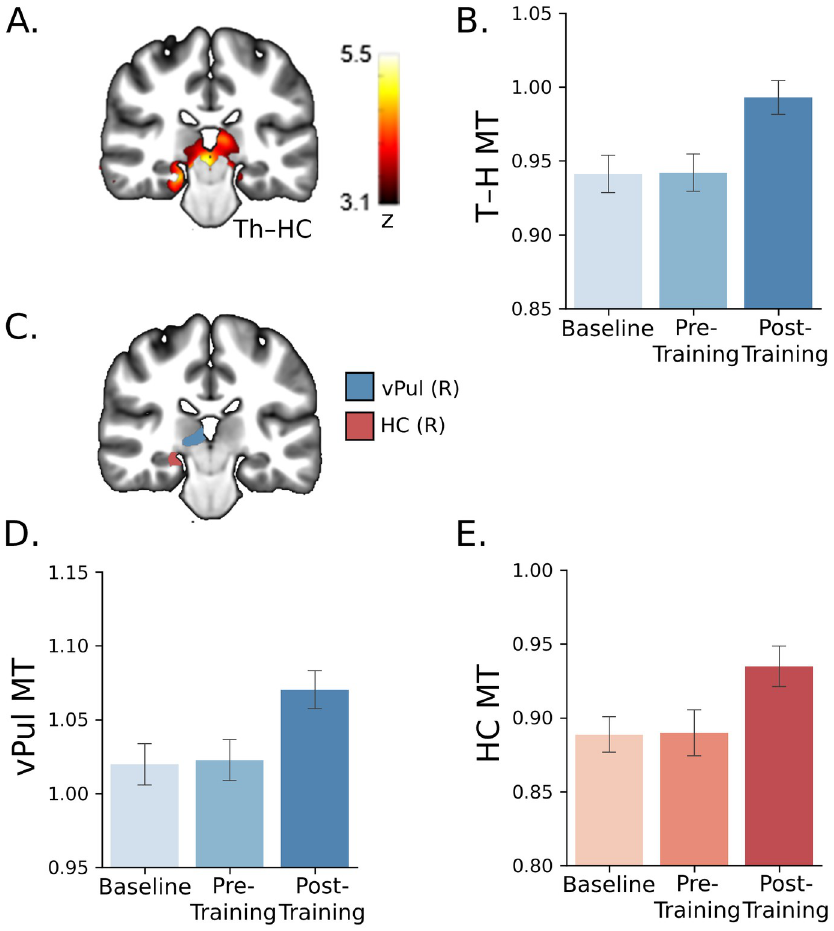
Fig 2. Subcortical MT saturation increases after training and correlates with behavioral improvement. ( A ) Th–HC cluster in MNI space (radiological convention, R-L; vPul x: 9.60 y: − 25.60 z: 0.80; HC x: 21.60 y: − 27.20 z: − 11.20 (mm)) showing significantly higher MT after (post-training) compared to before (baseline, pre-training) training ( p < 0.001) (S1 Table). ( B) Mean MT (percentage change from baseline session) in the Th–HC cluster before vs. after training. ( C ) Parcellation of the Th–HC cluster (see Methods for details): vPul (no overlap with LGN), HC (S2 Table). Higher mean MT in ( D ) vPul and ( E ) HC after compared to before training. ( n = 17). Error bars indicate SEM. Source data are provided at: https://doi.org/10.17863/CAM.93457. MT, magnetization transfer; HC, hippocampus; Th–HC, thalamic-hippocampal; vPul, ventral pulvinar.